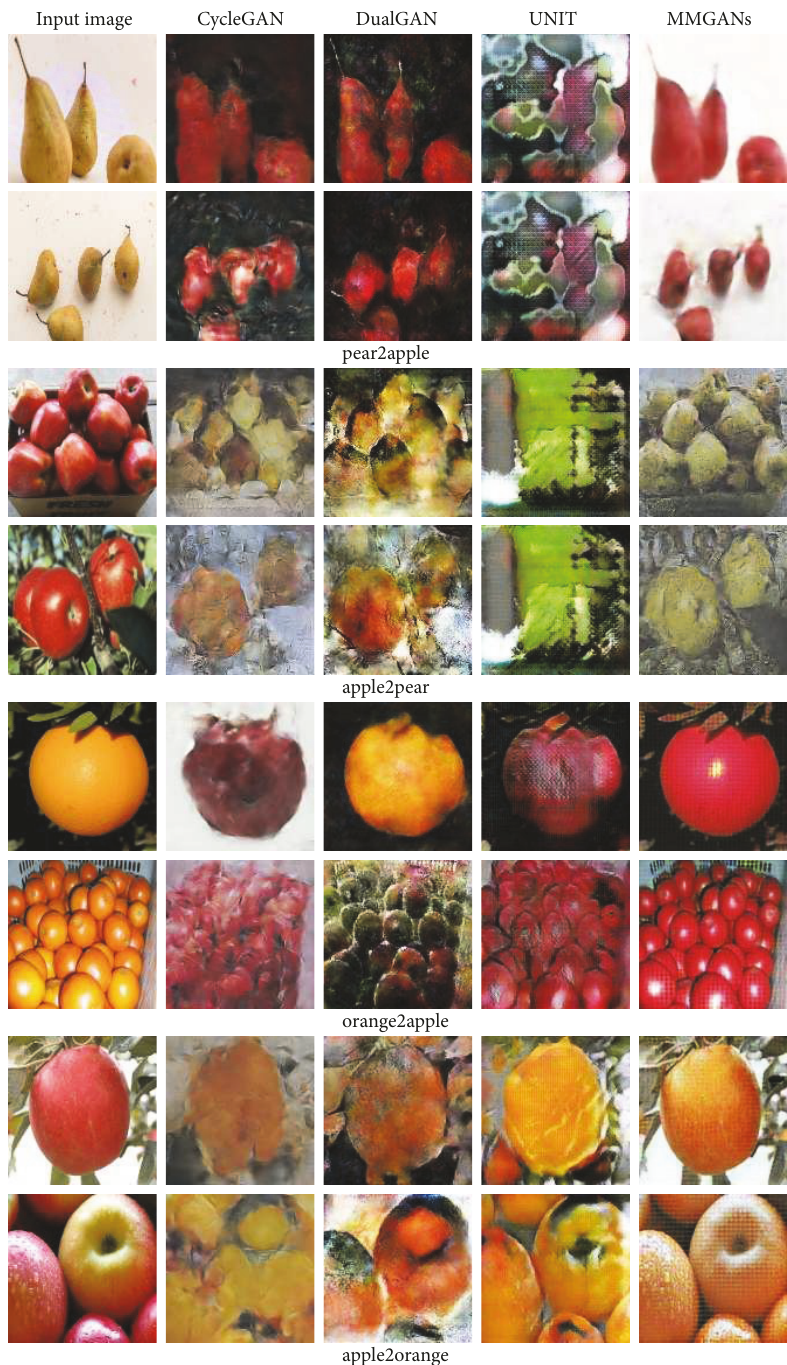
Figure 4: Generated images from test datasets. The left column is input image, then generated images with CycleGAN, DualGAN, UNIT, and MMGANs,